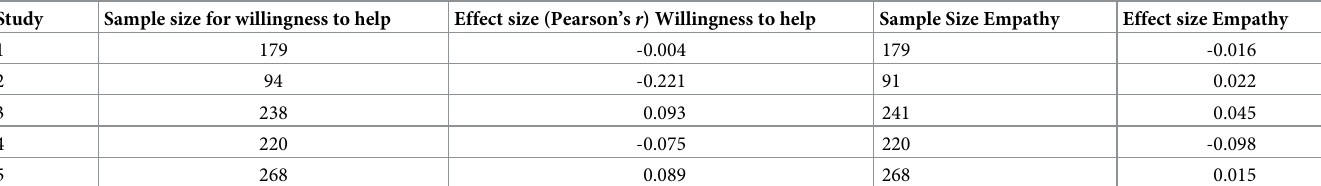
Table 1. Sample sizes and effect sizes regarding willingness to help and empathy in all